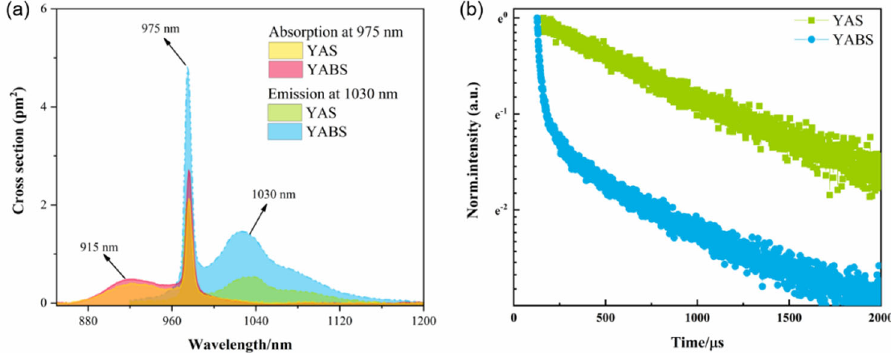
Figure 8. ( a ) Absorption and emission cross-sections and ( b ) Fluorescence lifetime decay curves of Yb 3+ ions in the YAS and YABS glass ( λ ex = 980 nm, λ em = 1030 nm). Table 3. Absorption cross-section at 975 nm, emission cross-section at 1030 nm, and fluorescence lifetime of Yb 3+ ions at 2 F 5/2 → 2 F 7/2 transition for YABS and YAS glass. YABS